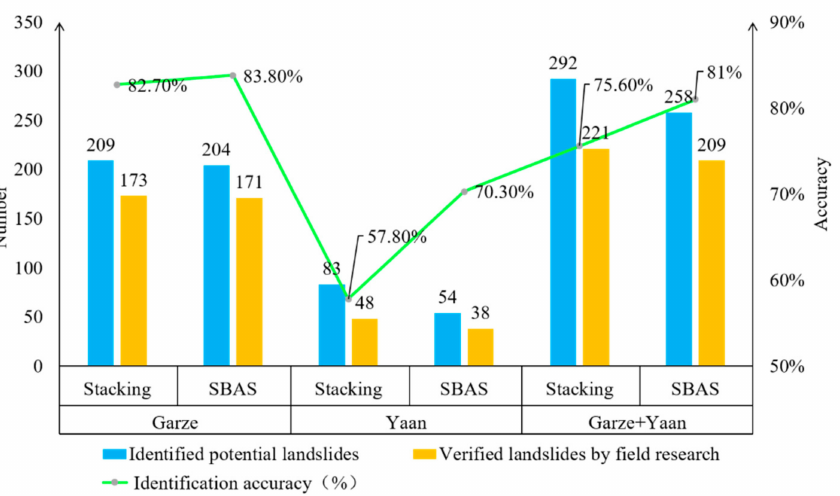
Figure 17. Statistics of landslide identification by SBAS technology and Stacking technology in different